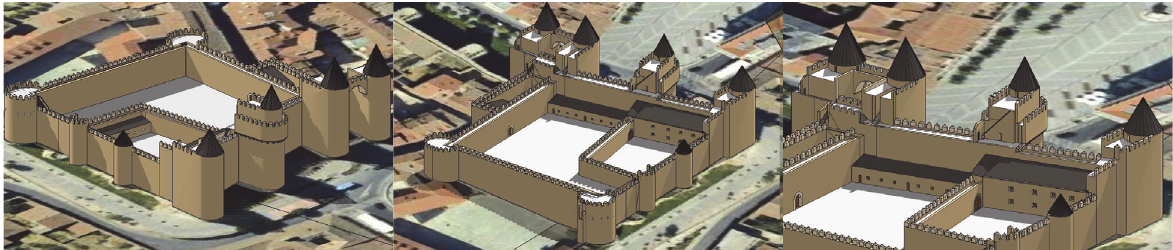
Figure 4. Intramural buildings: different views of the CAD modelling of the Alcázar anastylosis previous to mid-eighteenth